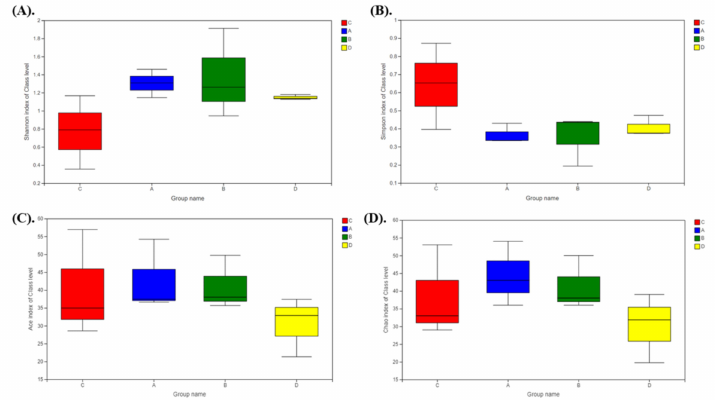
Figure 4. Box plots of intestinal microbiota diversity and richness in largemouth bass among each group after trial. ( A ) Shannon index of class level; ( B ) Simpson index of class level; ( C ) Ace index of class level; ( D ) Chao index of class